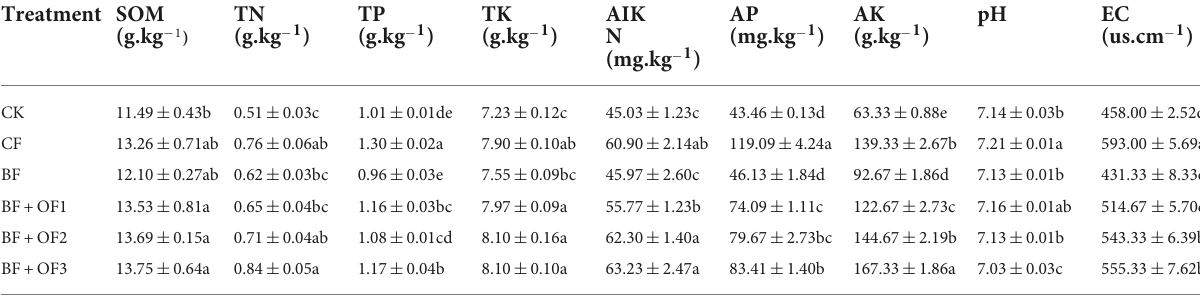
TABLE 3 Soil available nutrients and organic matter under different fertilization treatments. Treatment SOM (g.kg − 1